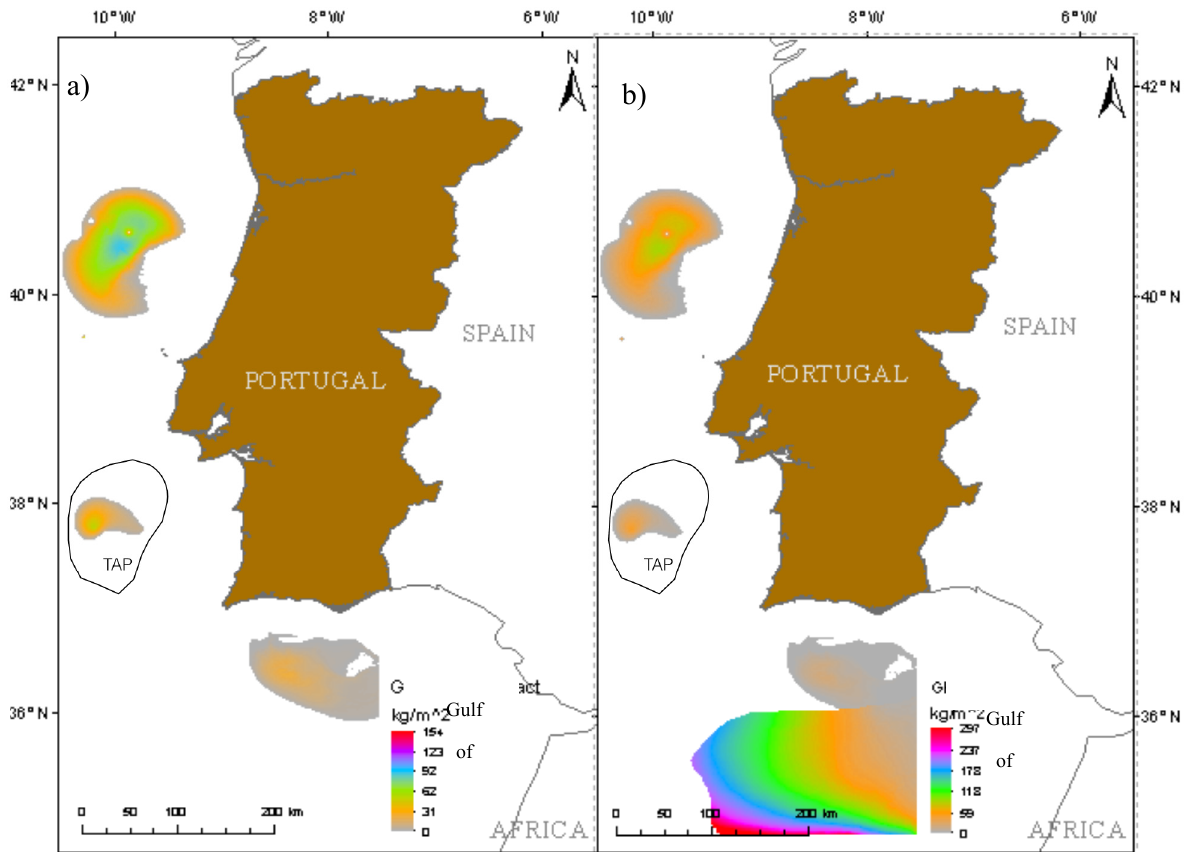
Figure 6. ( a ) GHI in the Full Compaction scenario; ( b ) GHI in the Full Compaction with fluid flow in the accretionary wedge ( q = 0.01